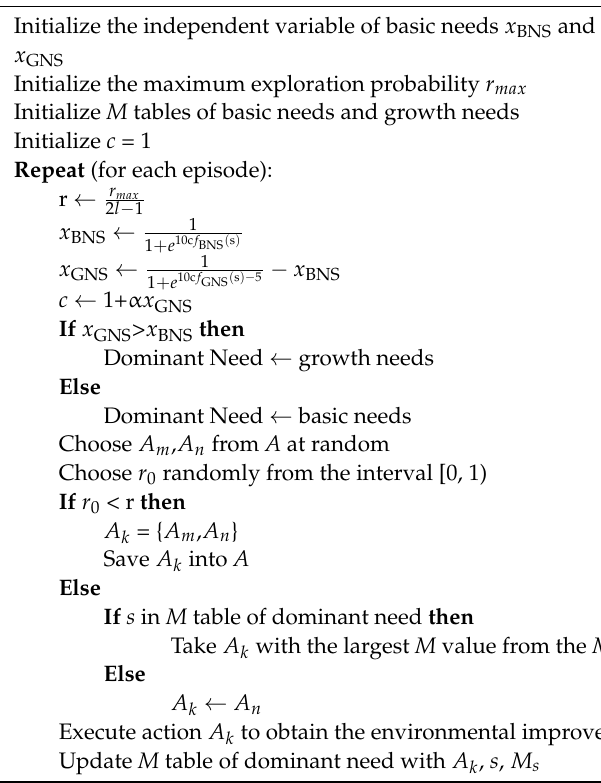
Algorithm 1 Needs learning